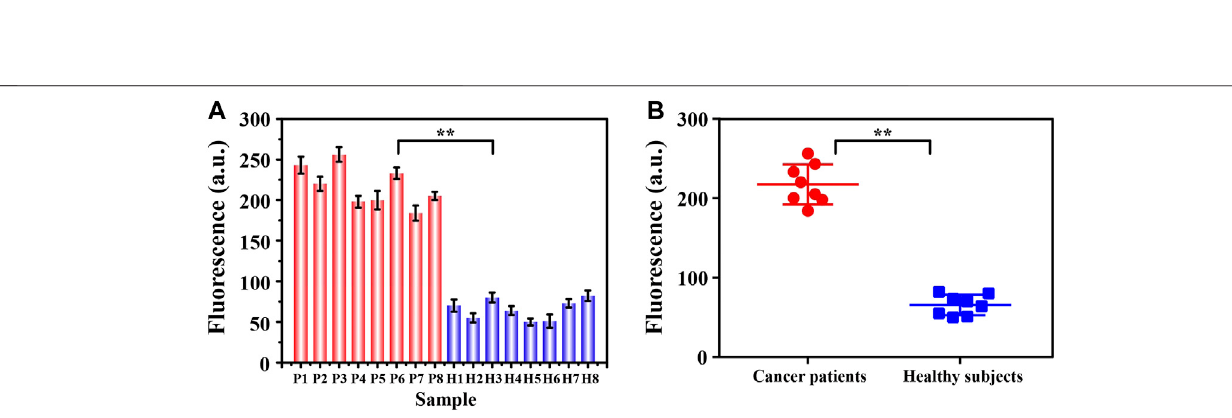
Frontiers in Bioengineering and Biotechnology |